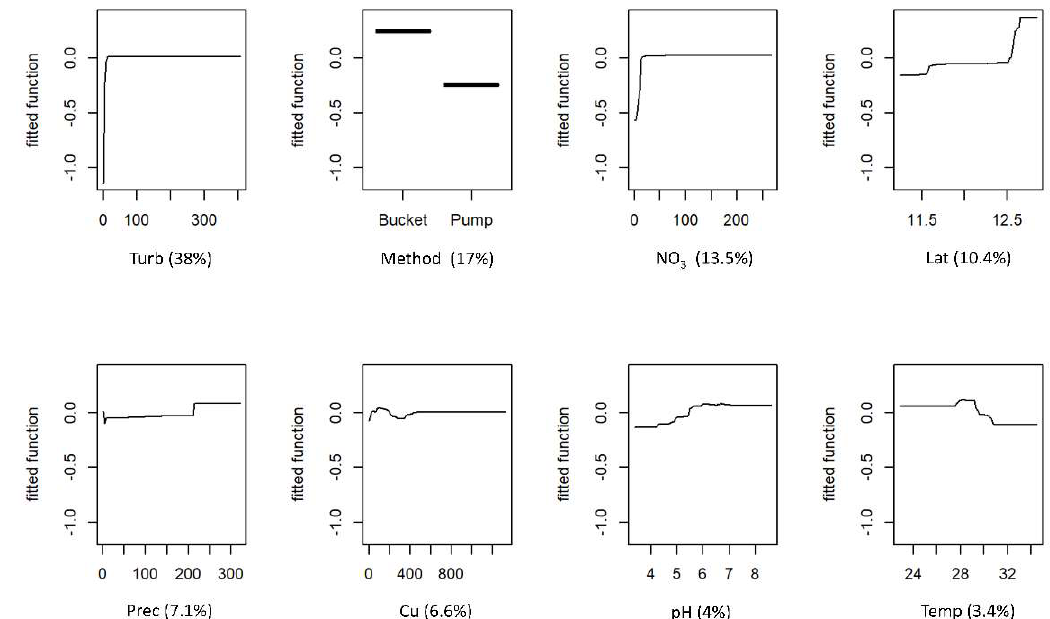
Figure 4. Boosted regression tree (BRT) partial dependence plots showing the effect of each predic- tor variable on intestinal enterococci (IE) of the water of wells in Guinea-Bissau: Turb—turbidity; Method—method used for water collection; NO 3 —nitrate; Lat—latitude; Prec—precipitation; Cu— copper; Temp—temperature. At each plot, the fitted function shows the relationship between the response variable ( y −axis), and the predictor variable ( x −axis), holding the values of all other varia- bles at their mean. The relative contribution (%) of each predictor variable for the BRT model is shown in brackets.